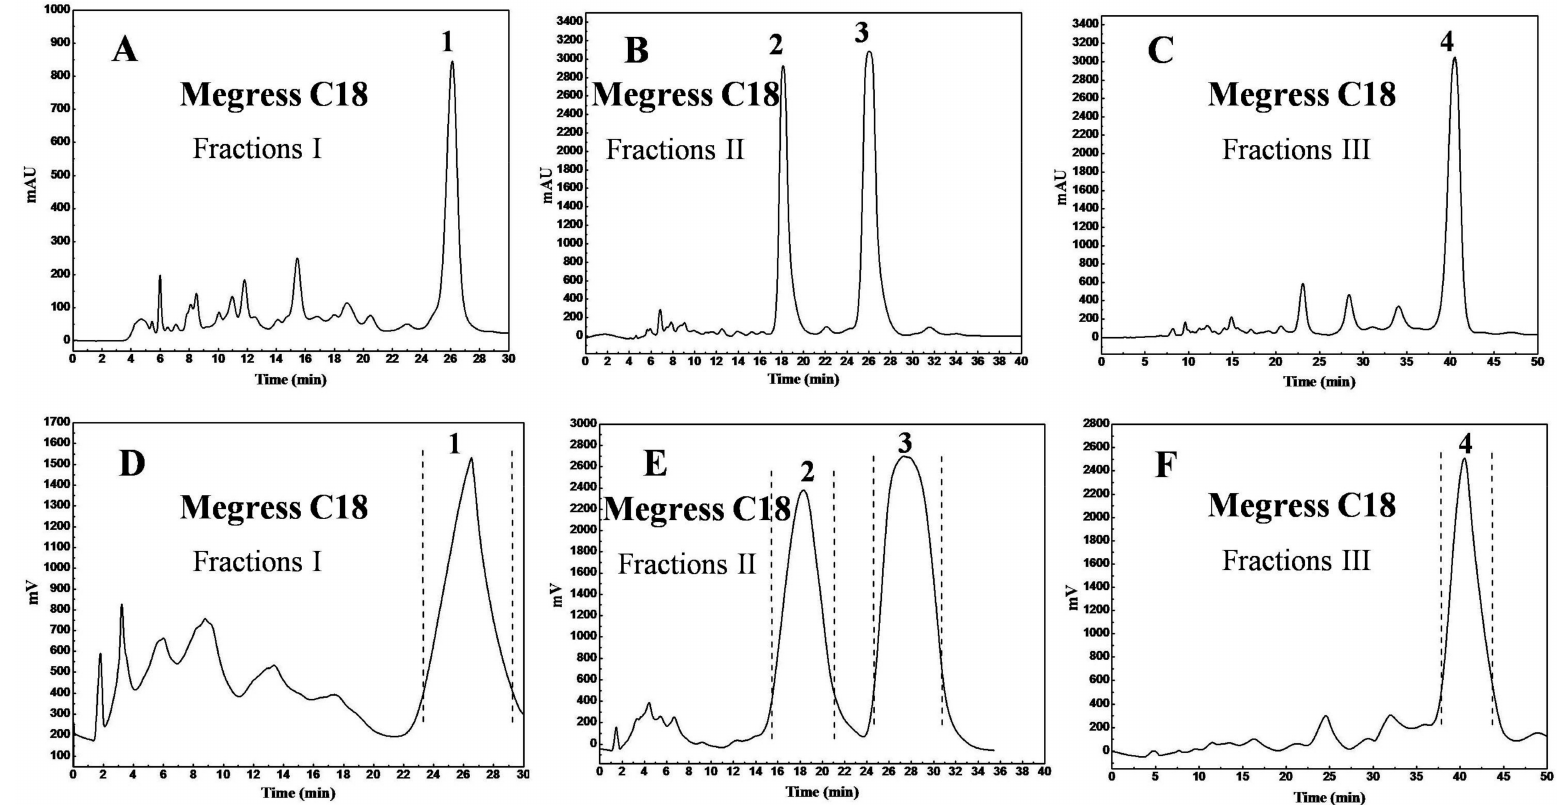
Figure 3. Analytical chromatograms of target fractions I ( A ), II ( B ), and III ( C ) on a Megress C18 analytical column and preparative chromatograms of target fractions I ( D ), II ( E ), and III ( F ) on a Megress C18 preparative column. The mobile phases for fractions I ( A , D ), II ( B , E ), and III ( C , F ) were the same: A: 0.2% v / v formic acid in water, and B: 0.2% v / v formic acid in methanol. Isocratic: 0–30 min, 85%~85% B for fraction I ( A , D ). Isocratic: 0–40 min, 80%~80% B for fraction II ( B , E ). Isocratic: 0–50 min, 80%~80% B for fraction III ( C , F ). The other conditions were the same: monitoring wavelength: 254 nm; flow rate: 1 mL/min; injection volume: 10 µ L; column temperature: room